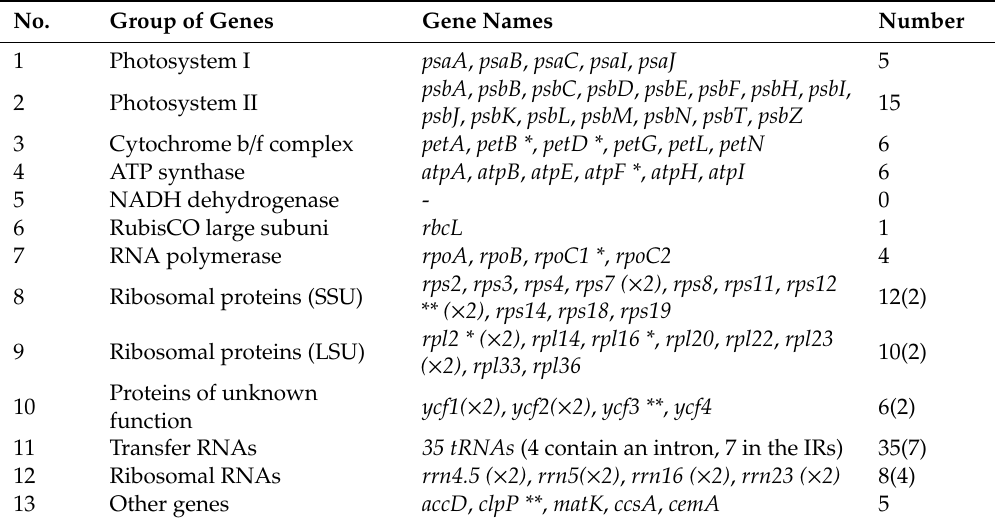
* One or two asterisks following genes indicate one or two contained introns, respectively. ( × 2) indicates that the number of the repeat unit is two. The numbers in parenthesis at the line of ‘Number’ indicate the total number of repeated